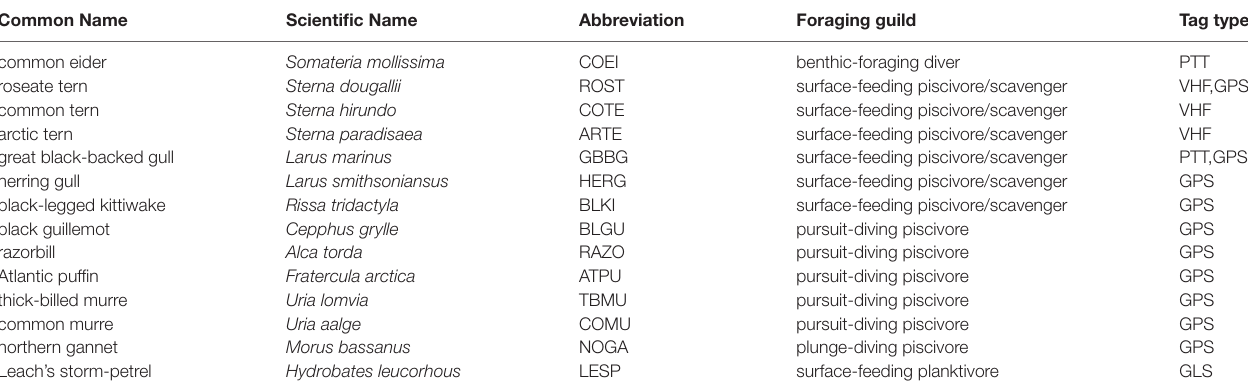
TABLE 1 | Study species names, abbreviations, foraging guilds, and tag types.